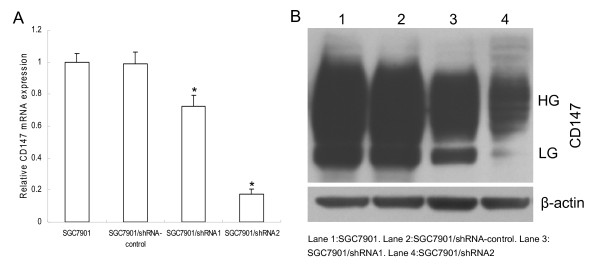
CD147 specific shRNAs results in the reduction of CD147 mRNA and protein levels in SGC7901 cells. (A). Relative mRNA levels were analysed by quantitative RT-PCR. β-actin was used as normalization control. *p < 0.01 compared with SGC7901. (B). Western blot analysis of CD147 protein expressions. β-actin was used as loading control. HG:high glycosylated form; LG: low glycosylated form.